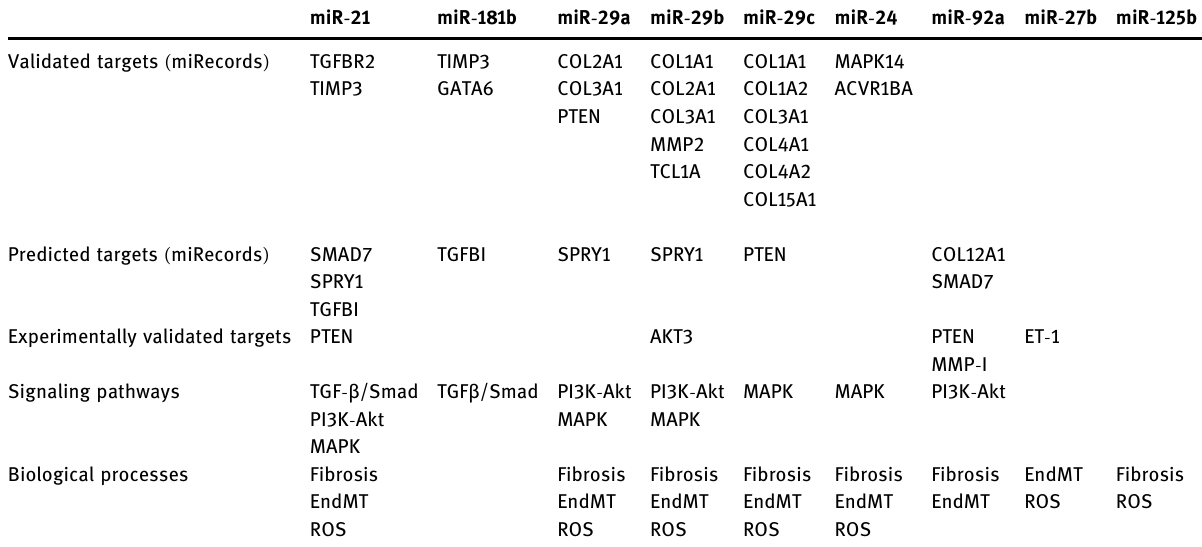
Table 2: Summary of the known information related to the miRNAs detected in this study miR -